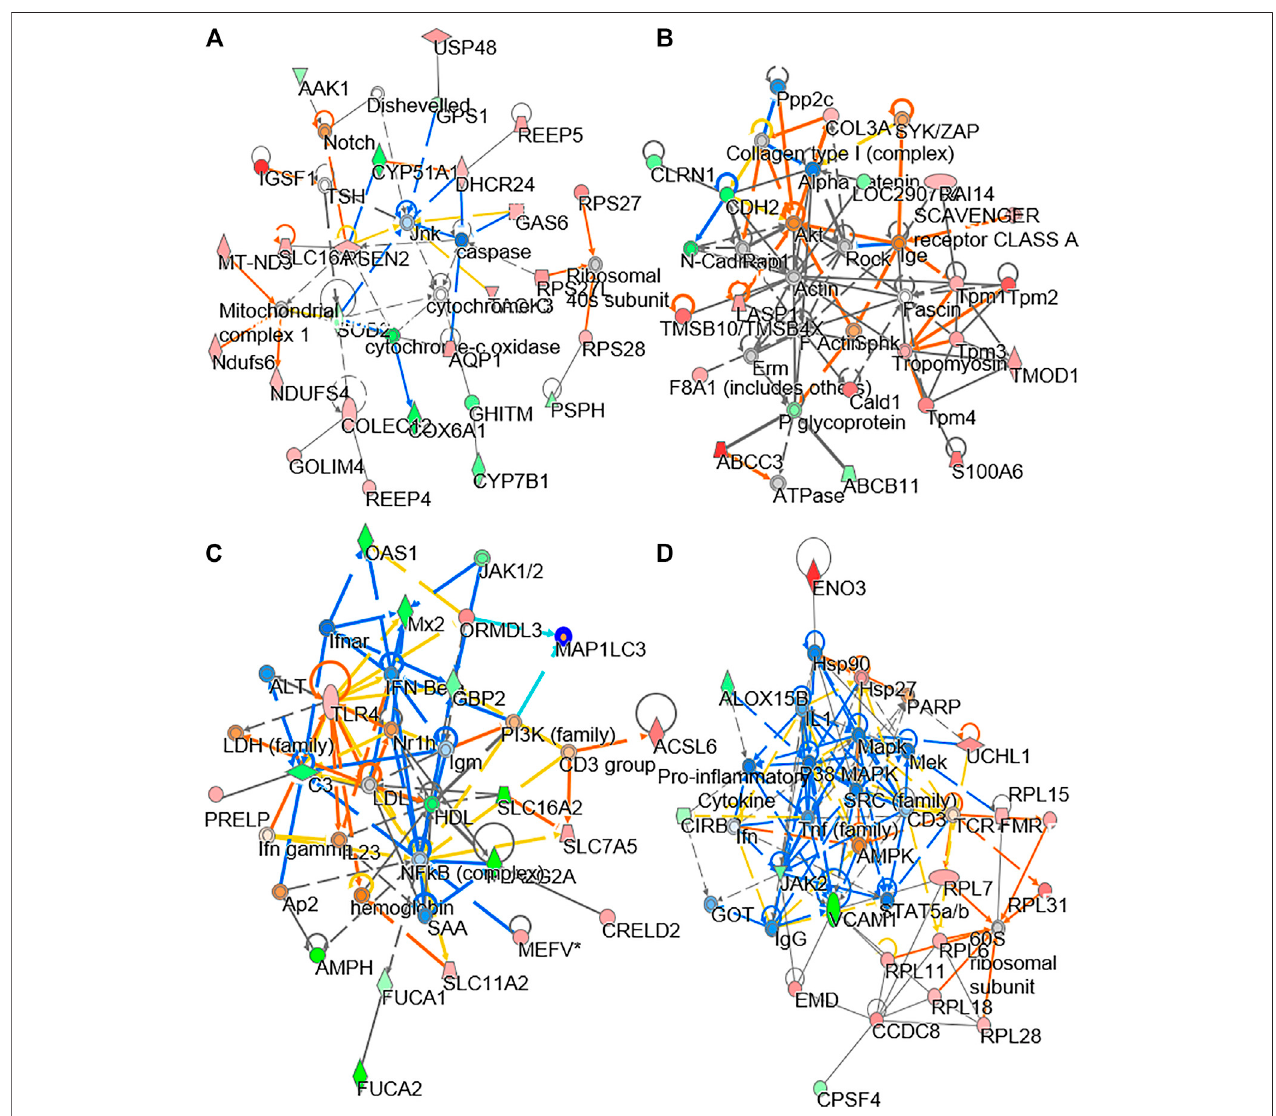
FIGURE 4 | Network analysis of proteomics data. The treatment of osteoblasts was as that in Figure 1 . From the proteomics data, the regulated protein in responding to treatments of DBT and DBT Δ cal was conducted by molecular network analysis. The network (A – D) was obtained by analyzing the DEPs using Ingenuity